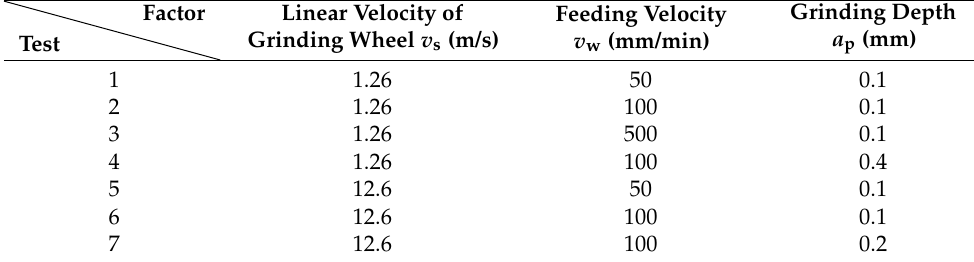
Table 1. C/SiC composite grinding parameters.